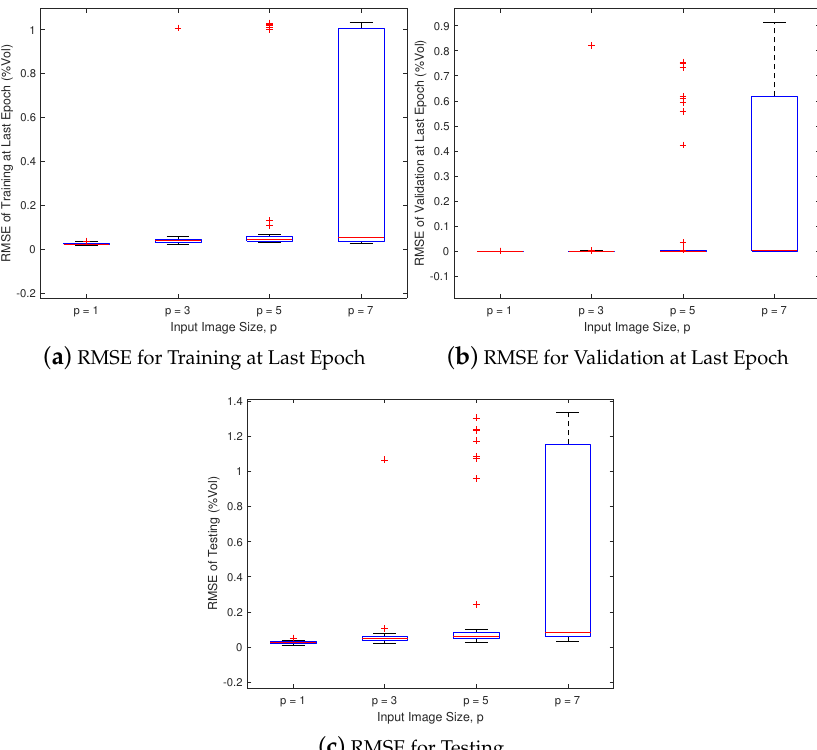
Figure 9. Training, validation, and testing results without errors on pixels for measurement points.